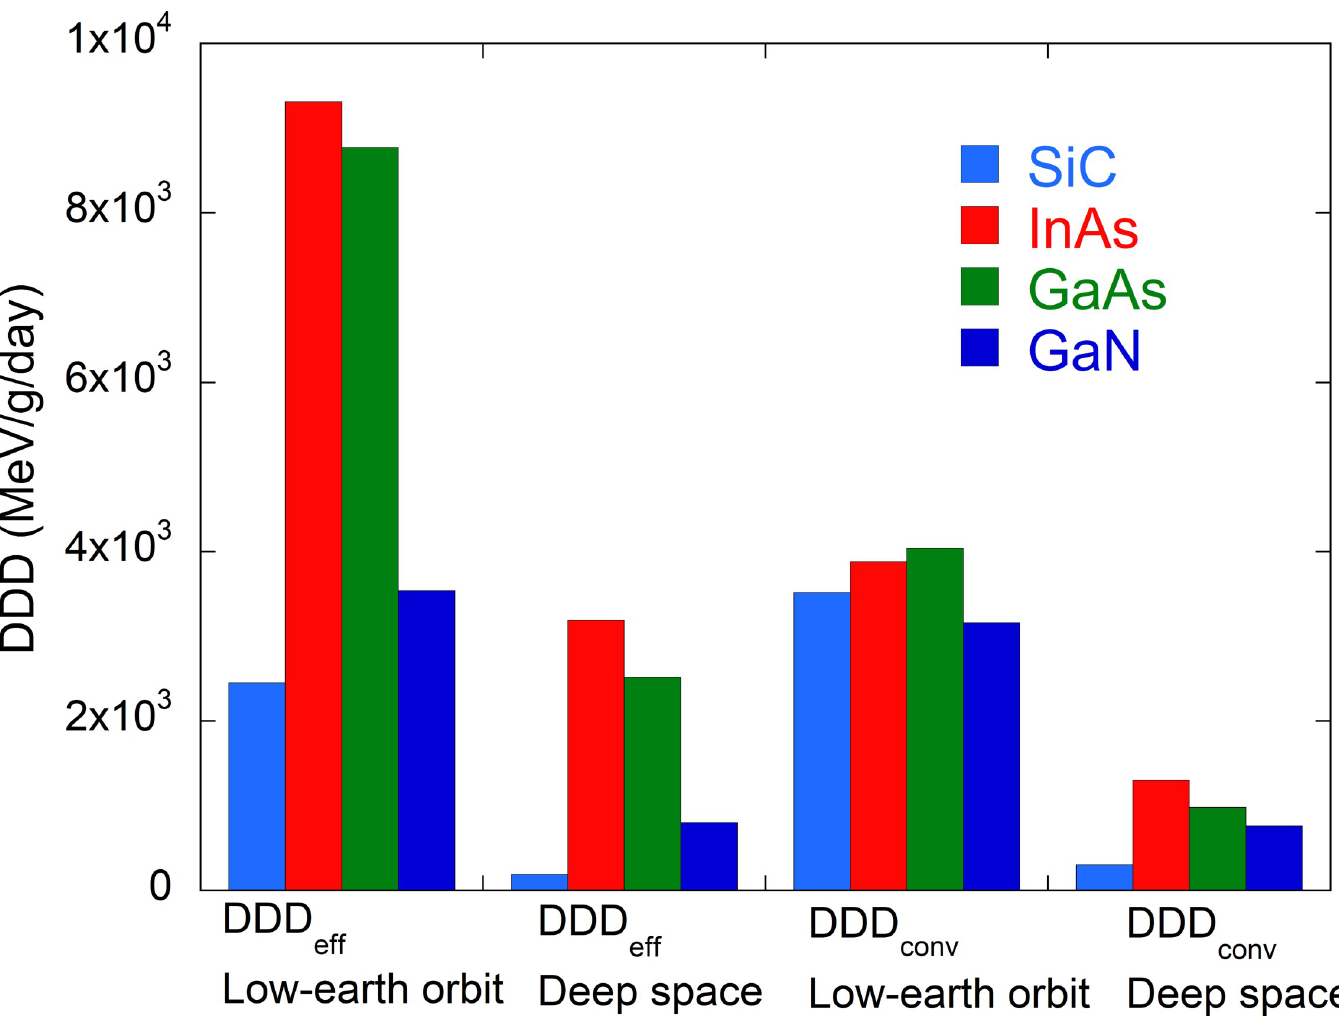
Fig 8. DDD eff and DDD conv values for low-Earth orbit and deep